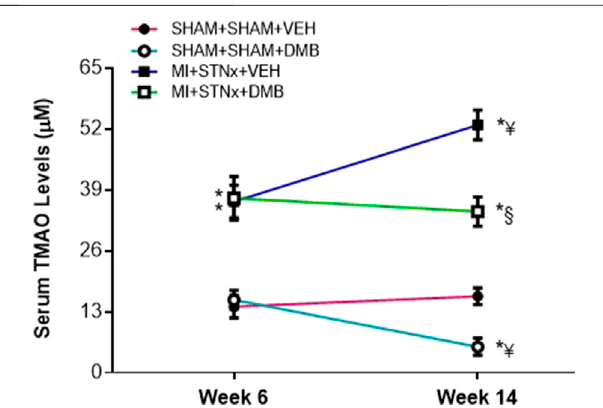
FIGURE 1 | Effects of cardiorenal syndrome type 2 (CRS2) and 3,3- Dimethyl-1-butanol (DMB, an inhibitor of trimethylamine formation) treatment on serum TMAO levels. CRS2 was induced by myocardial infarction (MI) followed by 5/6 subtotal nephrectomy (STNx). Sham MI (SHAM) and sham STNx (SHAM) animals served as control. VEH: vehicle treatment. Data are expressed as mean ± SE ( n (cid:1) 8 – 10 for each group). * p < 0.05 vs SHAM + SHAM+VEHateachtimepoint;¥ p < 0.05vsweek6;§ p < 0.05,MI+STNx+ DMB vs MI + STNx +